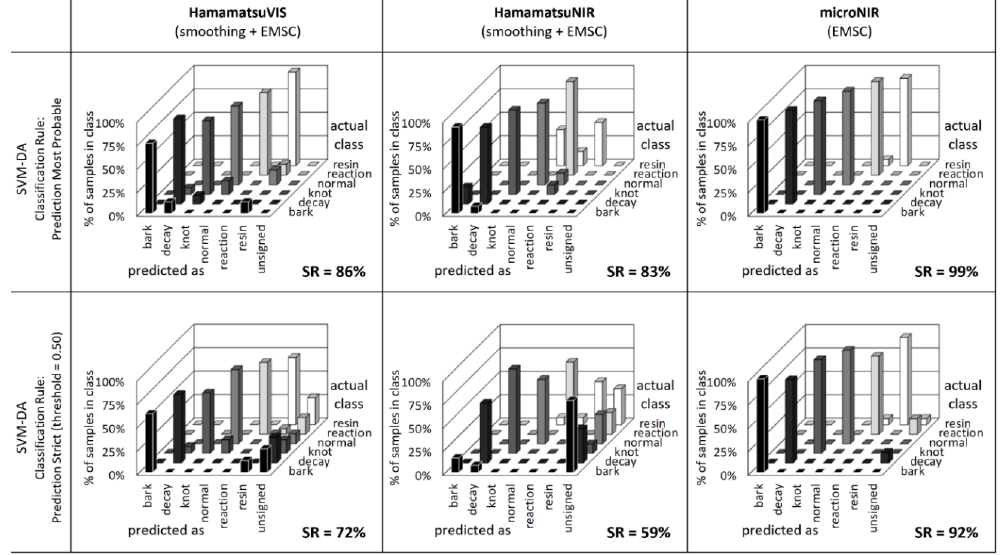
Figure 9. Automatic identification of defects on wood samples with Support Vector Machine (SVM) classification.